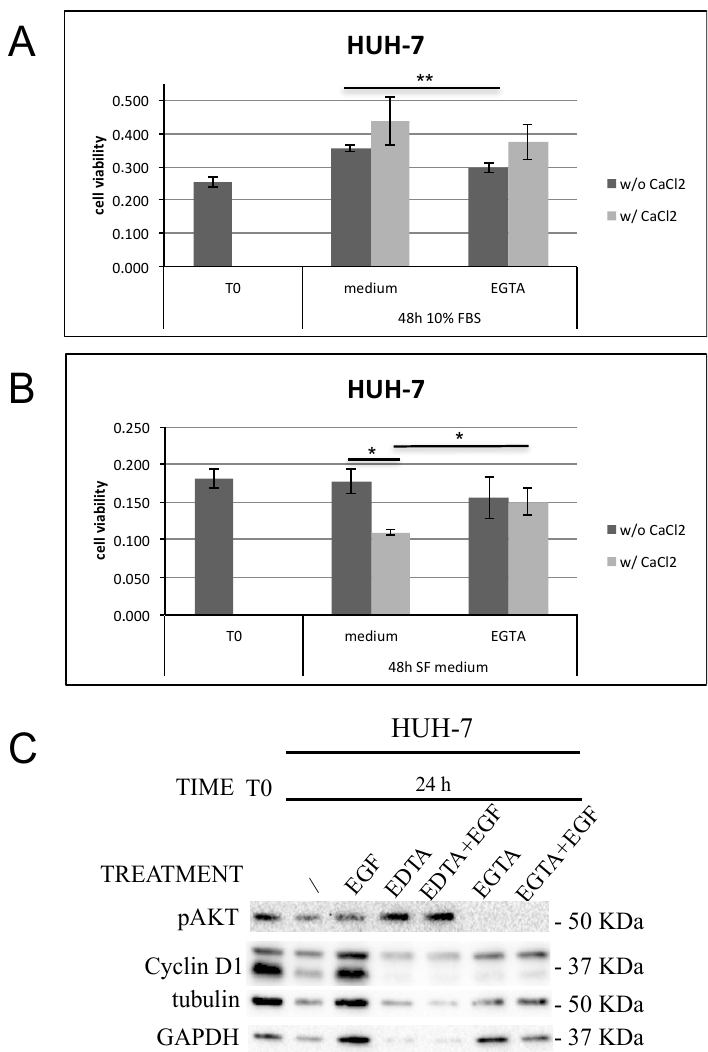
Figure 7. HUH-7 not starved (10% FBS ( A )) or starved (SF medium ( B )) cells were left untreated (medium as CTR) or treated with 2 mM EGTA for 48 h in the presence or absence of CaCl2. The cell signaling cascade was analyzed by western blot after 24 h ( C ). p value < 0.05 (*); p value < 0.01 (**). On the basis of these results, we tested EGTA treatment in association with the two EGFR inhibitors, GEF and AZ, at their respective IC50 values. In proliferating cells (whose proliferative capability is shown by the increased number of viable cells in the CTR medium bar versus the T0 bar), the combined treatment reduced the proliferative capability of cells using either GEF and AZ (Figure 8A). Conversely, as expected, in non-proliferating cells (the CTR medium bar and T0 bar displayed no di ff erences) EGTA combined with either drug led cells to maintain or even slightly increase their proliferative capacity, reverting the trend observed in proliferating cells (Figure